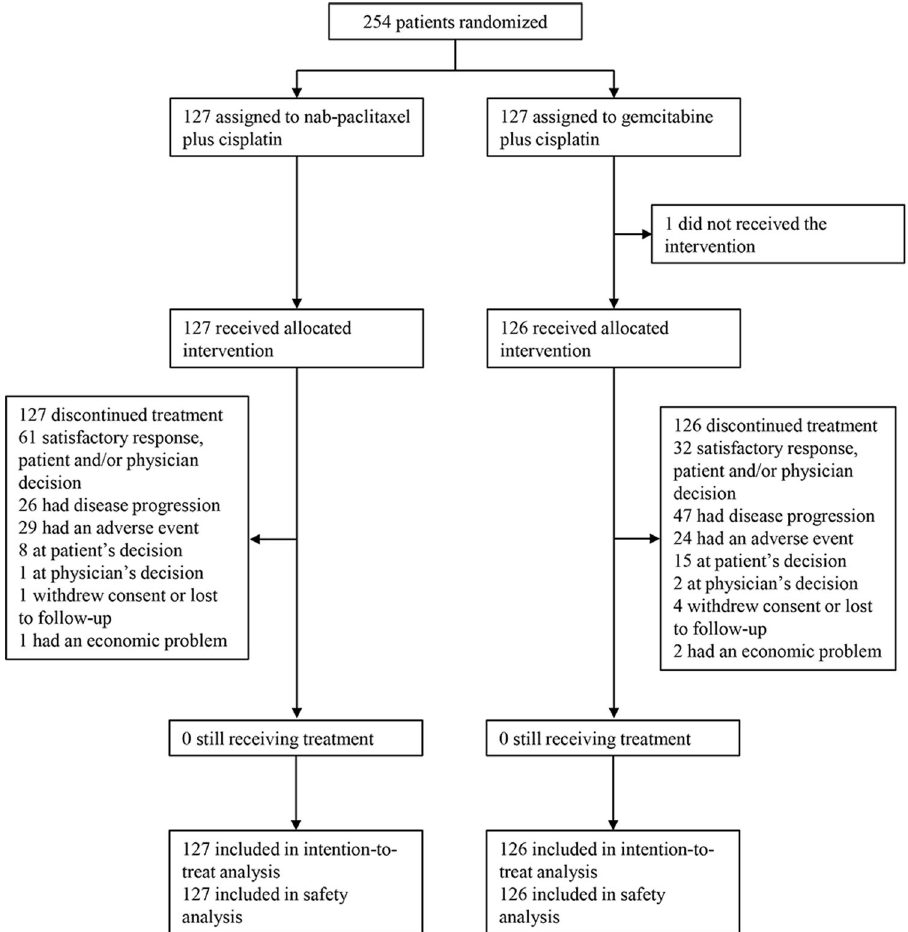
Fig. 1 Consort diagram of the GAP study. Patients may have discontinued the assigned treatment for multiple reasons. This fi gure shows the numbers of patients included in the intention-to-treatment and safety